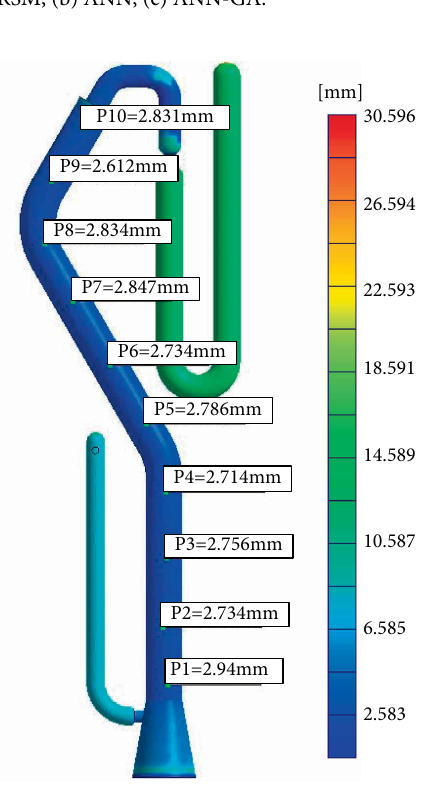
Figure 9: Simulation results with optimal process parameters.